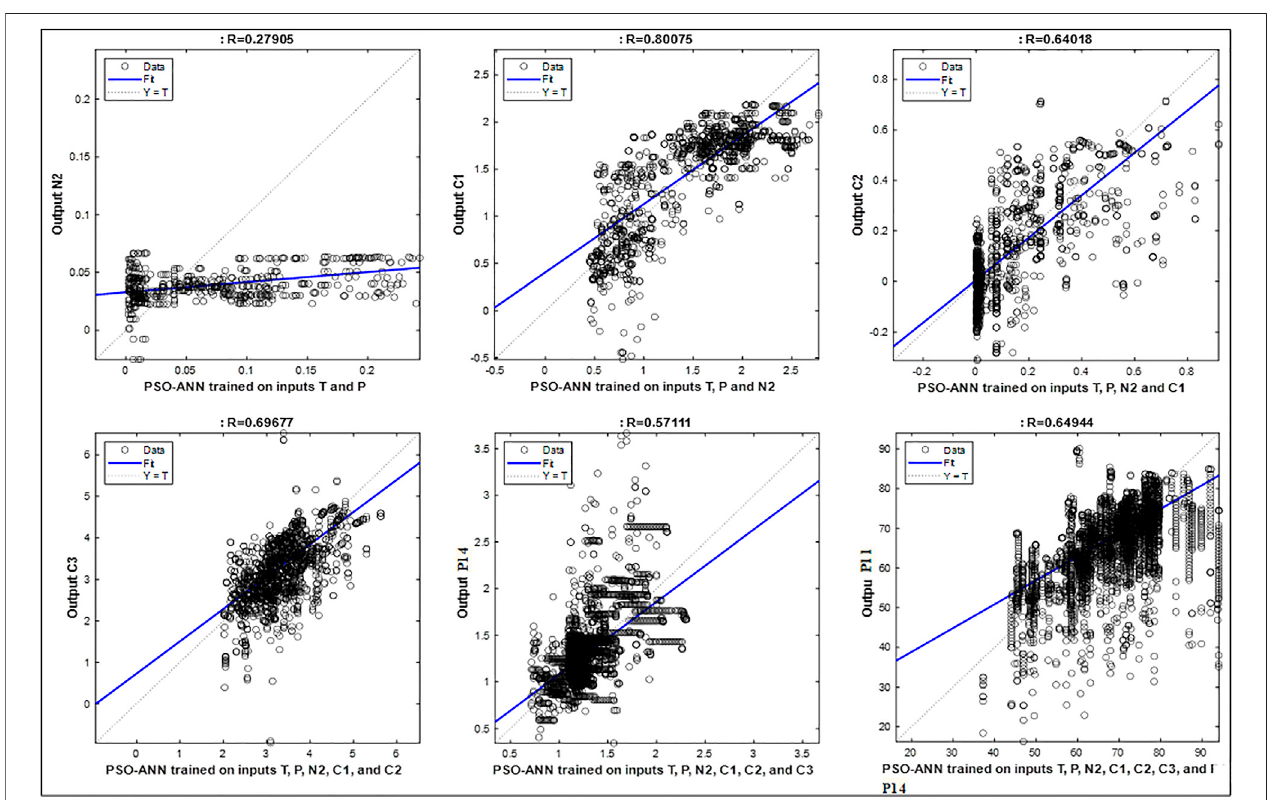
FIGURE 10 | Regression relationship between the trained PSO-ANN model and the corresponding dependent